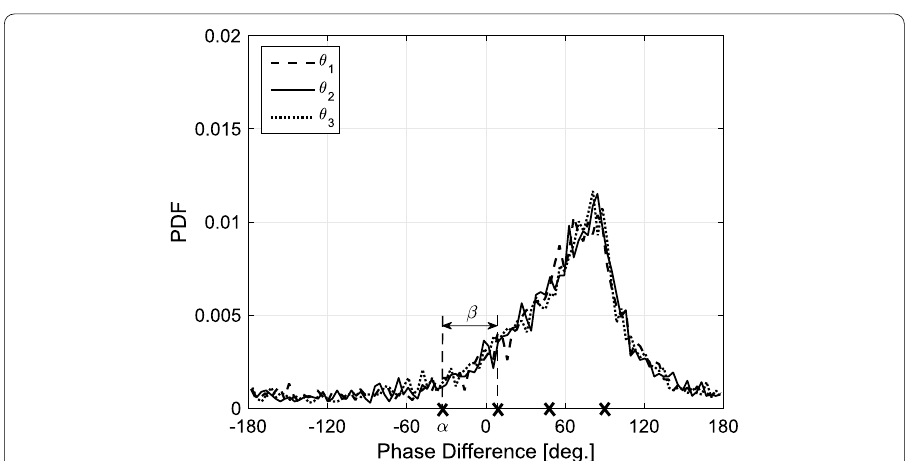
Fig. 6 Parametric codebook design for the ULA using parameters α and